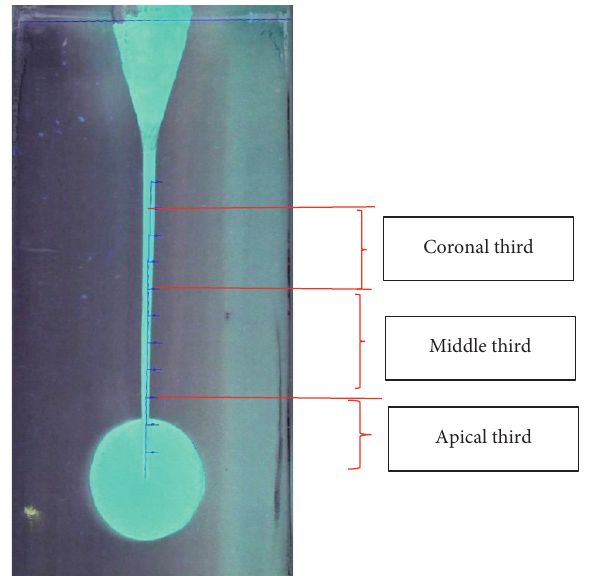
Figure 2: Pattern for transportation measurement of the lateral view of the